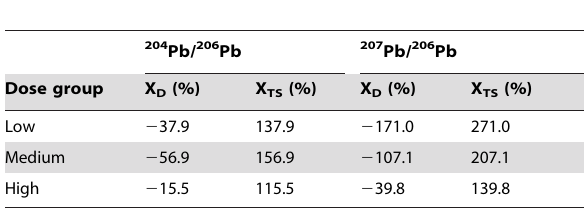
Table 6. The fractional contribution of diet and test substance in different dose group in blood